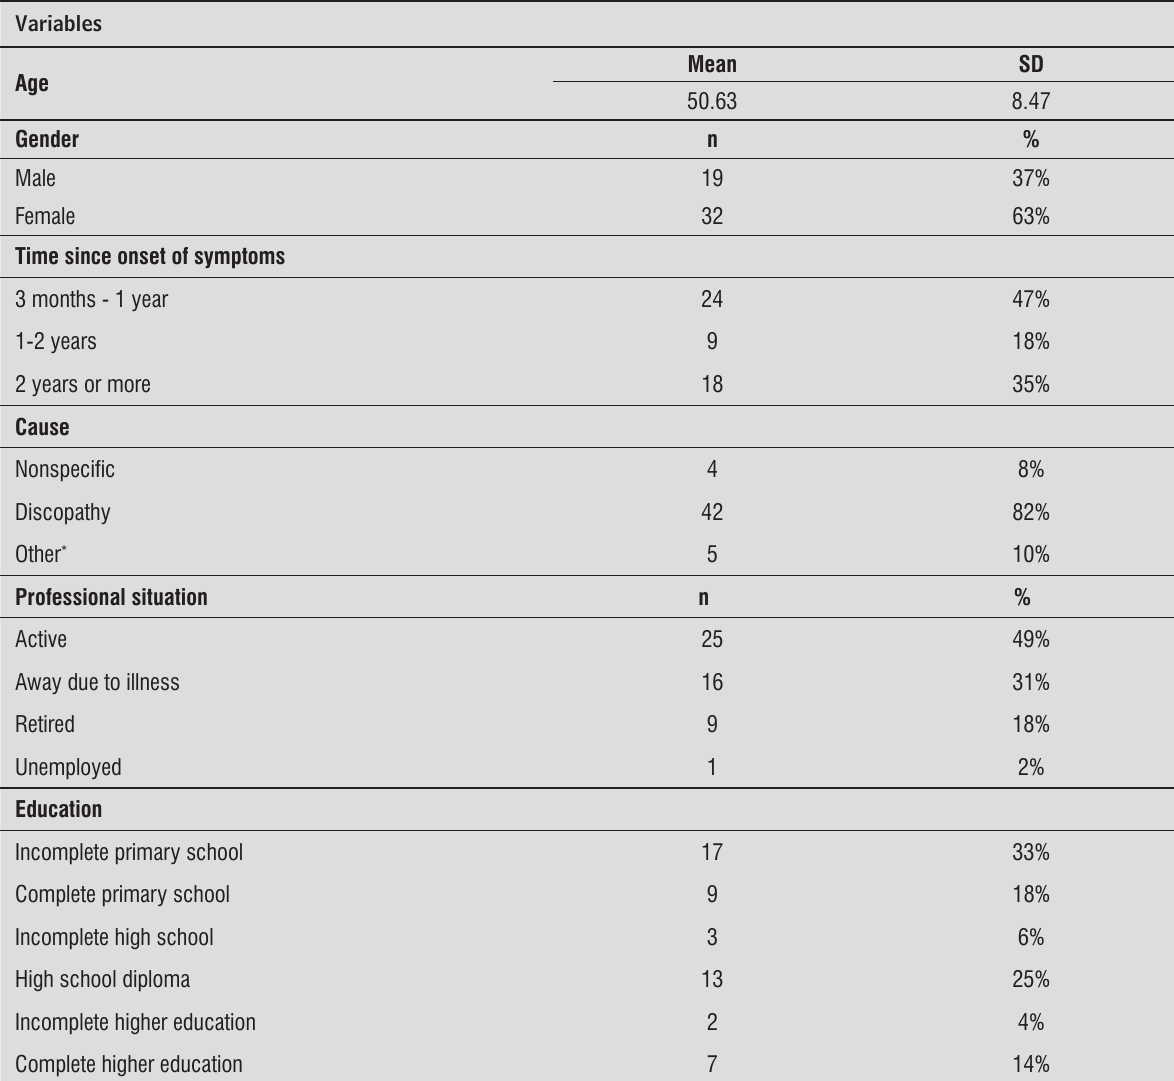
Table 1 - Clinical and socio-demographic characteristics of individuals with chronic low back pain